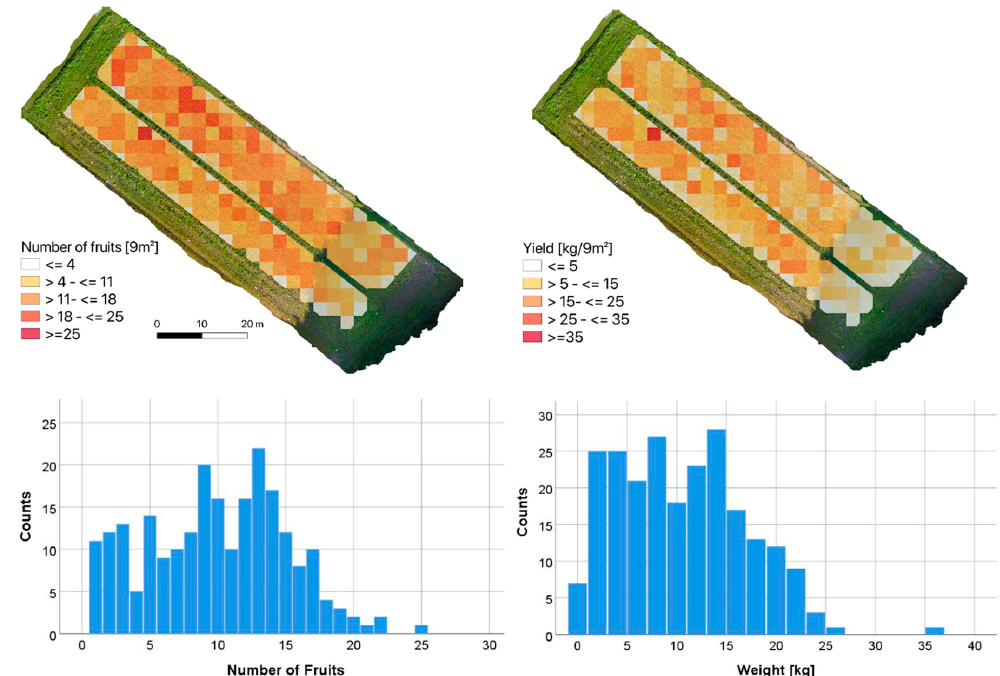
Figure 10. Spatial pattern of 9 × 9 m grid cells and frequency distributions for number of fruits (left) and weights (right). Looking at the south-eastern part of the field exhibits a different pattern compared to the rest of the field. In this area, the number of fruits, as well as the yield, were substan- tially below the rest of the field. This disparity shows the impact of the shading at the south-eastern edge with lower area-scaled average values. Besides this, no spatial pattern for the investigated field could be observed, neither for the number of fruits nor the yield. Linking the number of fruits per cell to the predicted weight provided a substantial relationship with an r of 0.882 (significant at 99% level). Obviously, the number of fruits within a 3 × 3 m cell is highly positively correlated with the yield per cell. 4. Discussion Many investigations described approaches for yield estimation from UAV-based im- ages for crops, like cereals or oilseed rape, that form yield from stands with uniform single plants [30–32]. Those concepts often use total aboveground biomass and derive grain yield by known or estimated harvest index. In addition, applications for orchards were de- scribed for estimating fruit yield from permacultures, like apple or citrus, where the trees remain on the field [12,13]. For vegetables, stand height or biomass-based applications were described for eggplants, tomato, and cabbage under tropical conditions in India [33]. Kalantar [14] presented a successful individual fruit detection for yield estimation in a melon field where leave senescence started before harvest. Here, we presented a novel method for precise yield prediction based on single fruit identification, including size and weight classification, that allows more detailed harvest determination from a vegetable field with Hokkaido pumpkins between living leaves and stems. 4.1. Methodologic Performance The pixel-based classification results using the RF classifier revealed high accuracies for both classes. However, it was found that fruit pixels were more often mistakenly clas- sified as non-fruit than vice versa. One reason can be the high heterogeneity of this class,